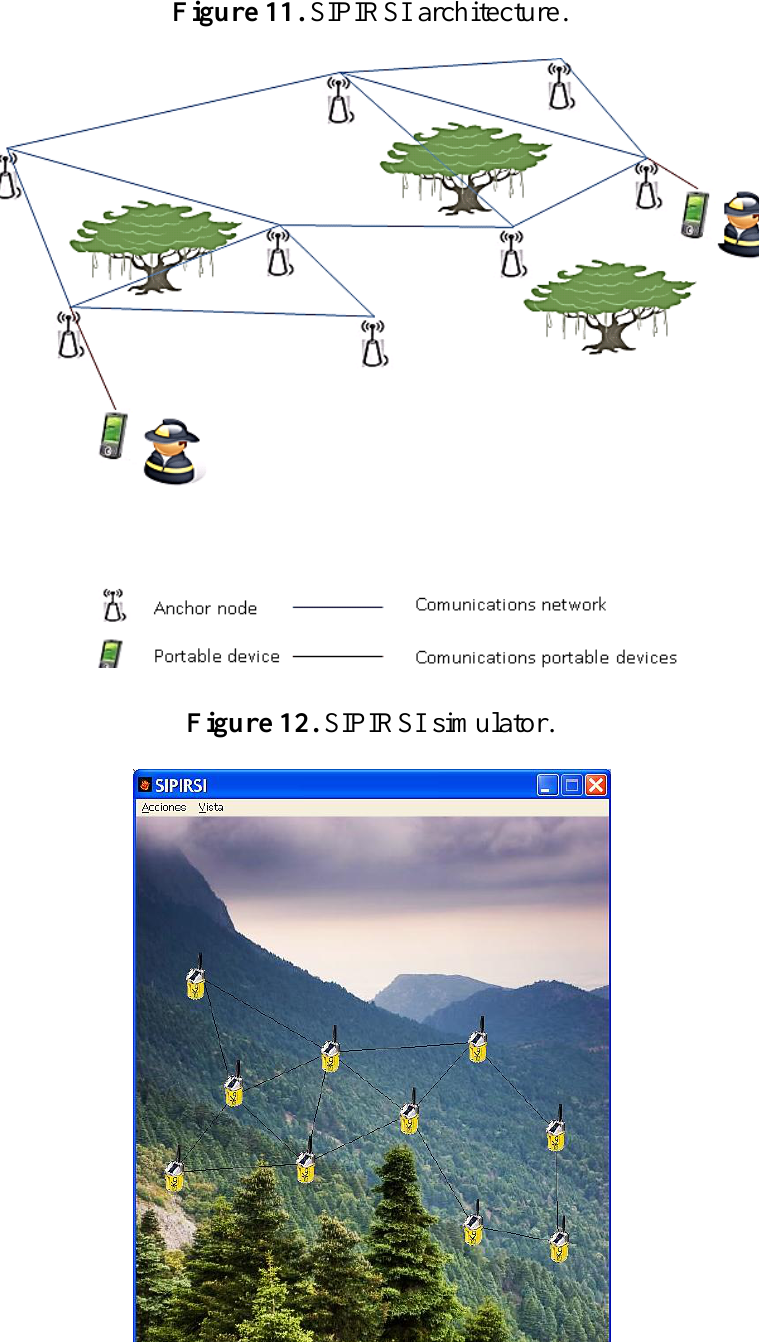
Figure 11. SIPIRSI architecture.